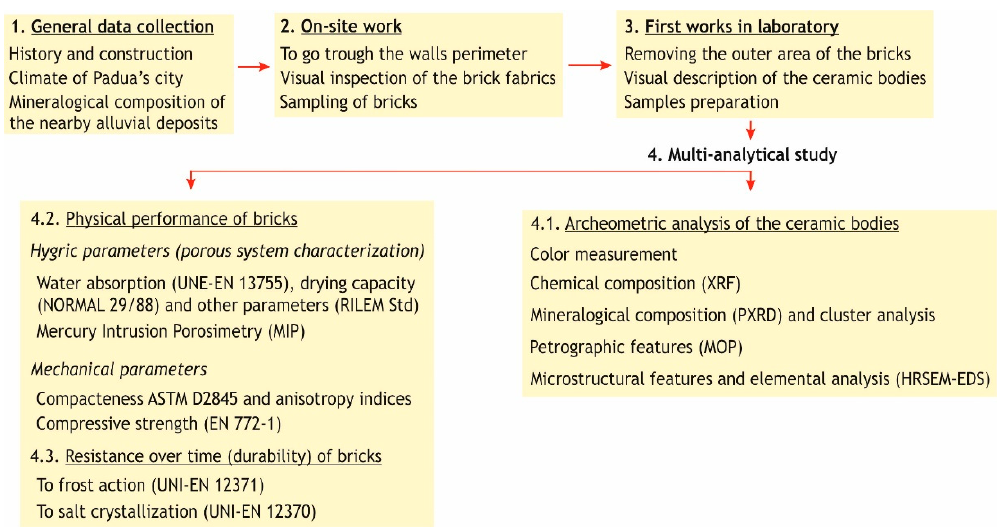
Figure 1. Flow chart of the interdisciplinary and multi-analytical study carried out on the original bricks that shape the Renaissance walls (16th century) of the city of Padua, Northeast Italy.